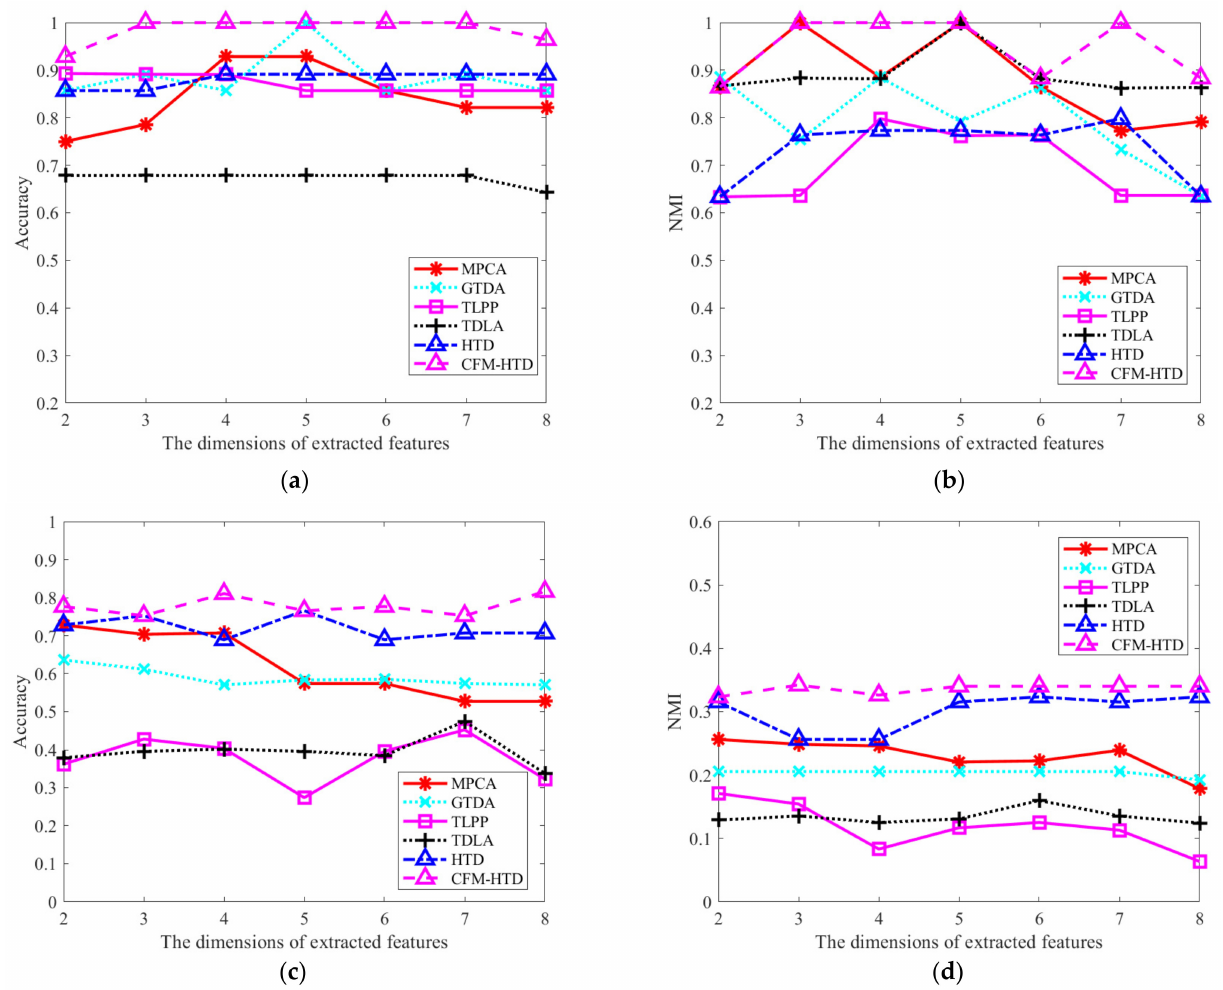
Figure 11. The accuracies and NMIs of CFM-HTD and the comparison methods under different dimensions of extracted features using two datasets. ( a ) The accuracies of CFM-HTD and the comparison methods using dataset 1; ( b ) the NMI of CFM-HTD and the comparison methods using dataset 1; ( c ) the accuracies of CFM-HTD and the comparison methods using dataset 2; ( d ) the NMI of CFM-HTD and the comparison methods using dataset